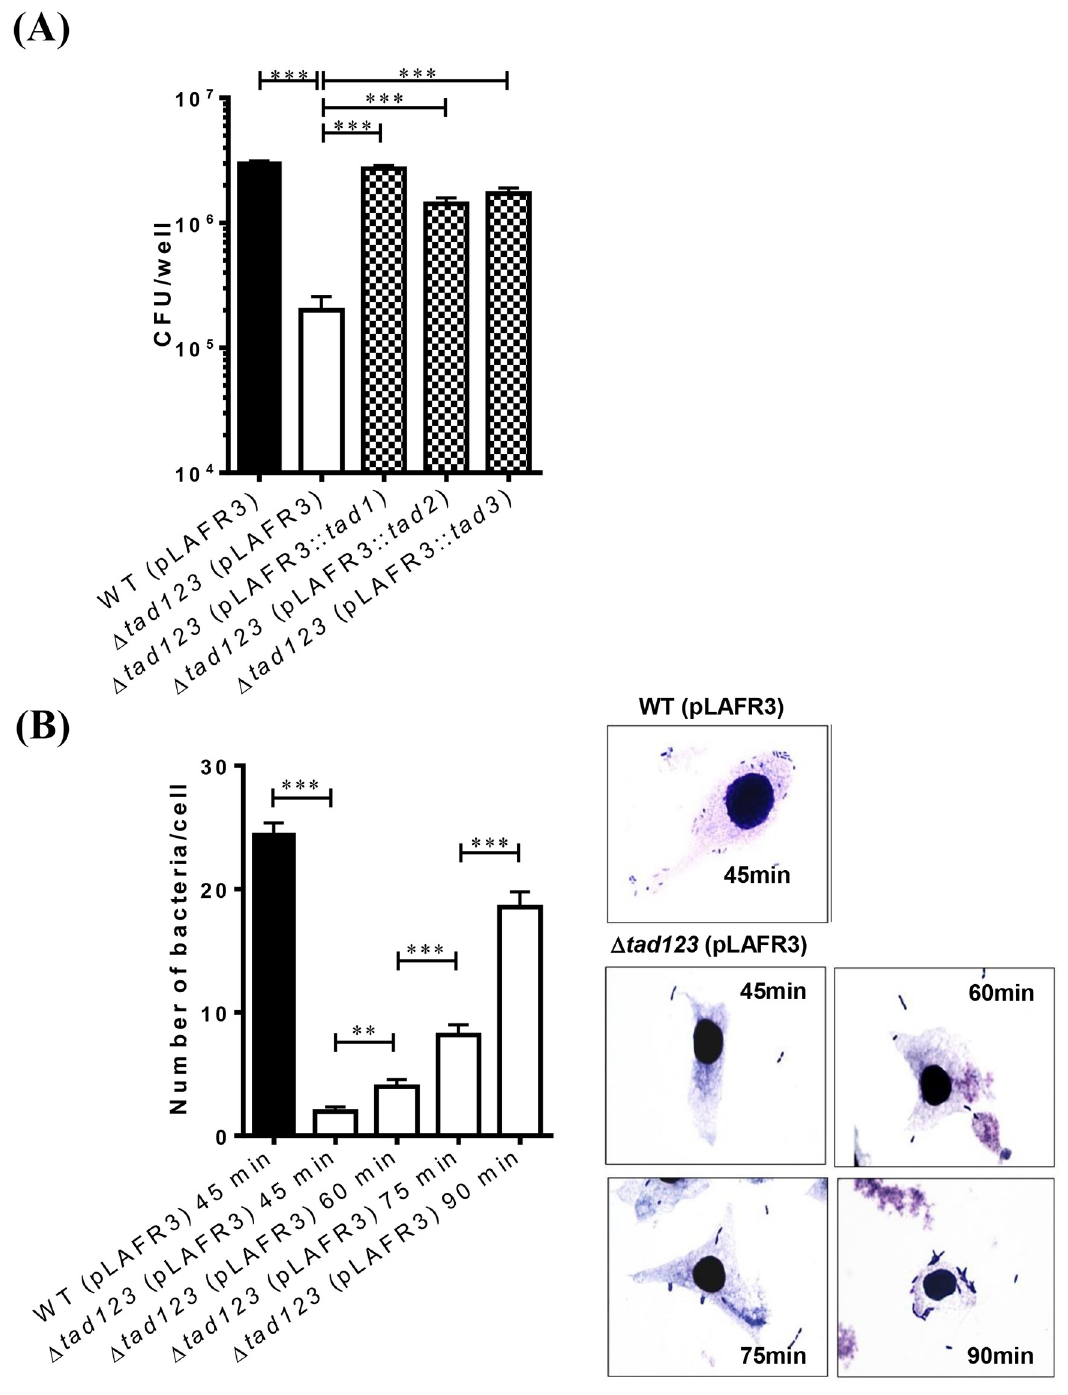
Fig 2. Significantly decreased adhesion to host cells by the Δ tad123 mutant (A) and time-dependent recovery (B). HeLa cells were treated with log-phase V . vulnificus cells at an MOI of 250 bacteria in the presence of 2 μ g/ml tetracycline, and the bacterial cells that adhered to HeLa cells were counted at appropriate time points. The morphology of the infected HeLa cells was observed after Giemsa staining at × 1,000 magnification. Data shown represent the mean ± SEM of five independent experiments performed with six (A) or seventeen to forty-four replicates (B) . WT (pLAFR3), wild type harboring pLAFR3; Δ tad123 (pLAFR3), Δ tad123 mutant harboring pLAFR3; Δ tad123 (pLAFR3:: tad1 ), Δ tad123 mutant in trans complemented with pLAFR3:: tad1 locus; Δ tad123 (pLAFR3:: tad2 ), Δ tad123 mutant in trans complemented with pLAFR3:: tad2 locus); Δ tad123 (pLAFR3:: tad3 ), Δ tad123 mutant in trans complemented with pLAFR3:: tad3 locus. Statistical analysis was carried out using Student’s t test ( �� , P < 0.01).